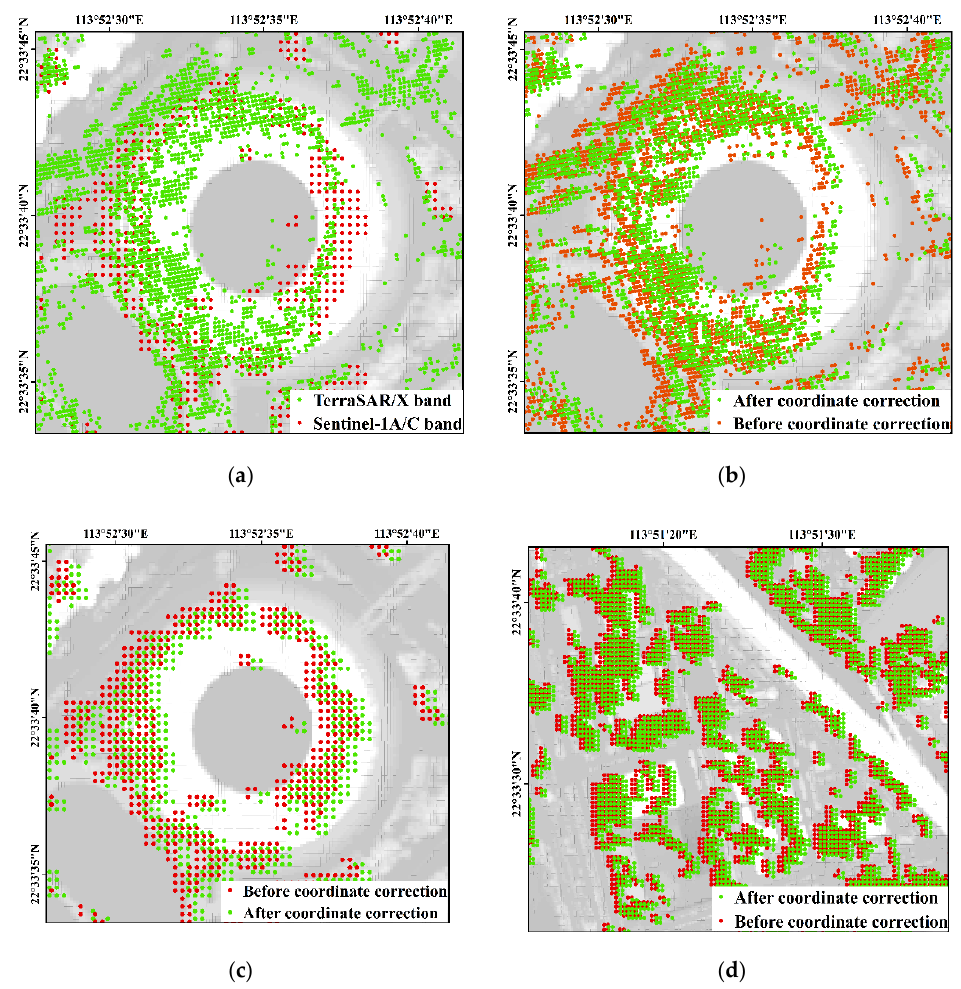
Figure 7. ( a ) Superposition effect of SAR PS points based on two bands and DSM data. Red and green represent the PS points based on Sentinel-1A and TerraSAR-X images, respectively; ( b ) geo- metric correction of TerraSAR-X subsidence for buildings; ( c , d ) geometric correction of Sentinel-1A subsidence for buildings. Table 4. Statistics of geometric correction results of building PS points.